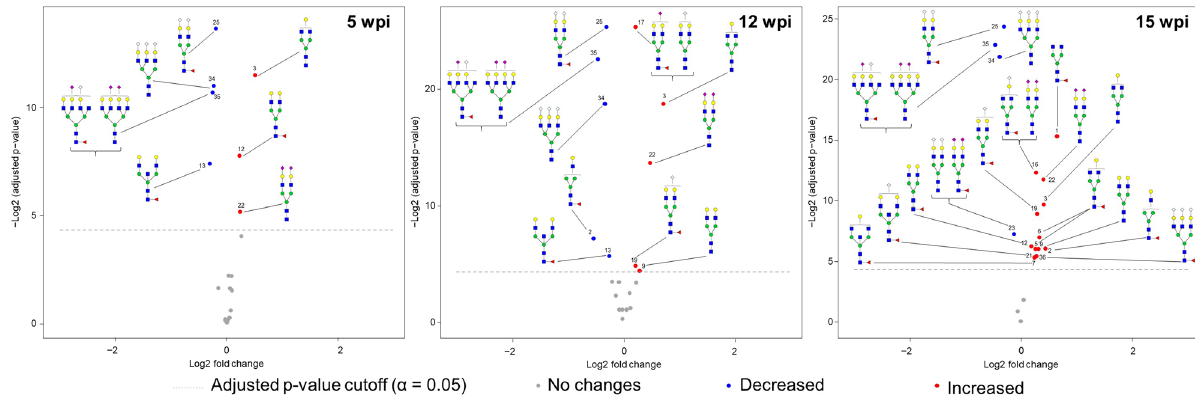
Figure 6. Changes in the major HILIC-UPLC glycopeaks of the rhesus macaque serum N-glycan profile upon infection with B. malayi . Glycopeaks from the HILIC-UPLC profiles of healthy rhesus macaque serum N-glycans with areas above 0.5% of the total profile area at baseline (pre-infection) were selected. Changes in the relative abundance of the 20 glycopeaks resulting from this selection were studied across infection by comparing the post-infections time-points: 5 ( A ), 12 ( B ) and 15 ( C ) weeks post-infection (wpi)—with pre-infection (baseline). Adjusted p-values were determined using linear-mixed effect models (Supplementary Table S4 online) and volcano plots were generated for data visualization. The X-axis of the plot corresponds to the log2 fold changes of glycan abundance and the y-axis to the negative log2 of the adjusted p-values. The horizontal dashed line represents the threshold of significance α = 0.05. All glycopeaks showing significant differences between baseline and infected time-points are indicated by a colored datapoint (red = increase, blue = decrease). Corresponding N-glycan structures are represented using the CFG nomenclature (see Fig. 1 inset), adjacent to the datapoint corresponding to each glycopeak, numbered according to elution in the HILIC-UPLC profile (Fig. 4.A and Supplementary Fig. S1